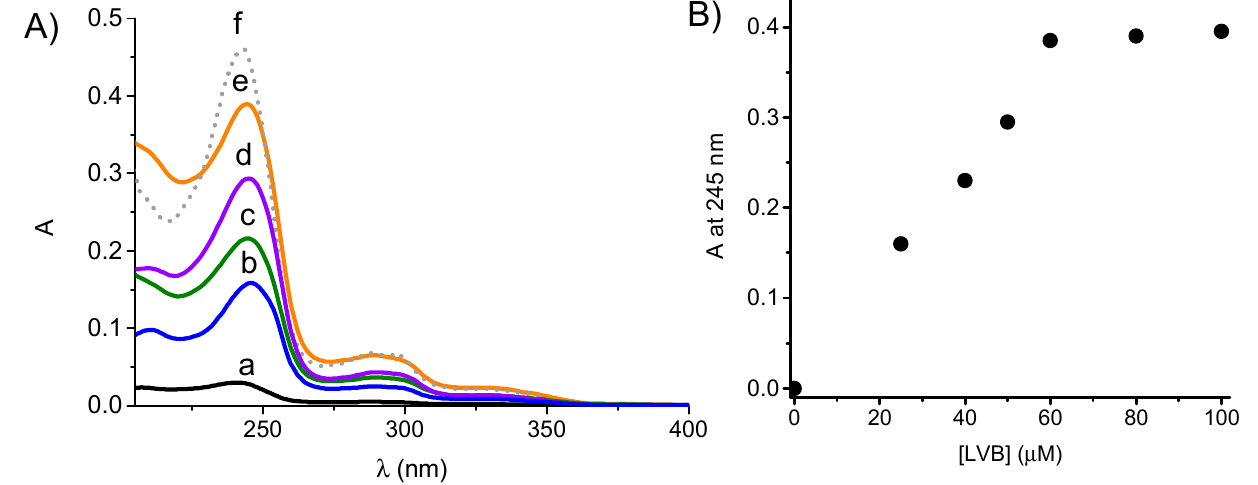
Figure 1. ( A ) Absorption spectrum of LVB in PBS (pH 7.4) at 4.1 µM (a) and in the presence of